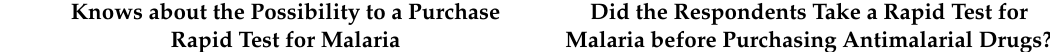
2. Performing a rapid diagnostic test for malaria before purchasing antimalarial drugs. Table 2. Knowledge about malaria tests by age of Table 2. Knowledge about malaria tests by age of respondents.